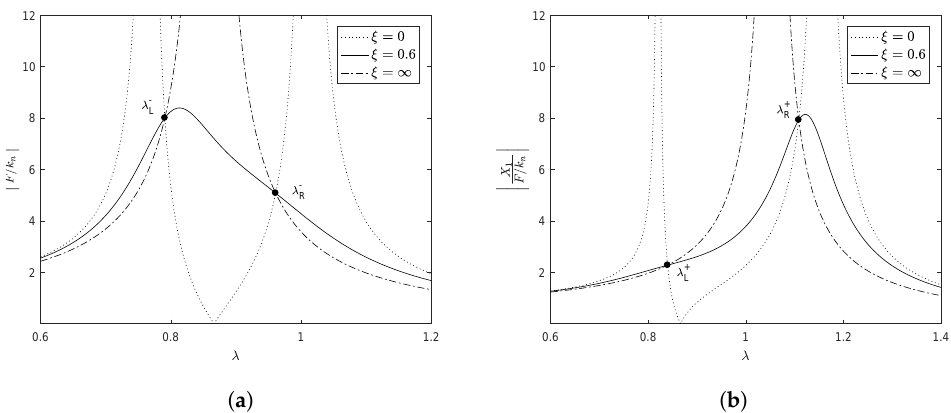
Figure 3. Frequency responses of an uncertain primary system controlled by a TMDI corresponding to three damping levels: ( a ) δ = − β and ( b ) δ = + β . The set of parameters used for simulation was µ = 0.05, ν = 0.03, β = 20%, and f = 1.2. Dotted line: ξ = 0; solid line: ξ = 0.6; and dashed-dotted line: ξ = ∞ . In each case, two fixed points were